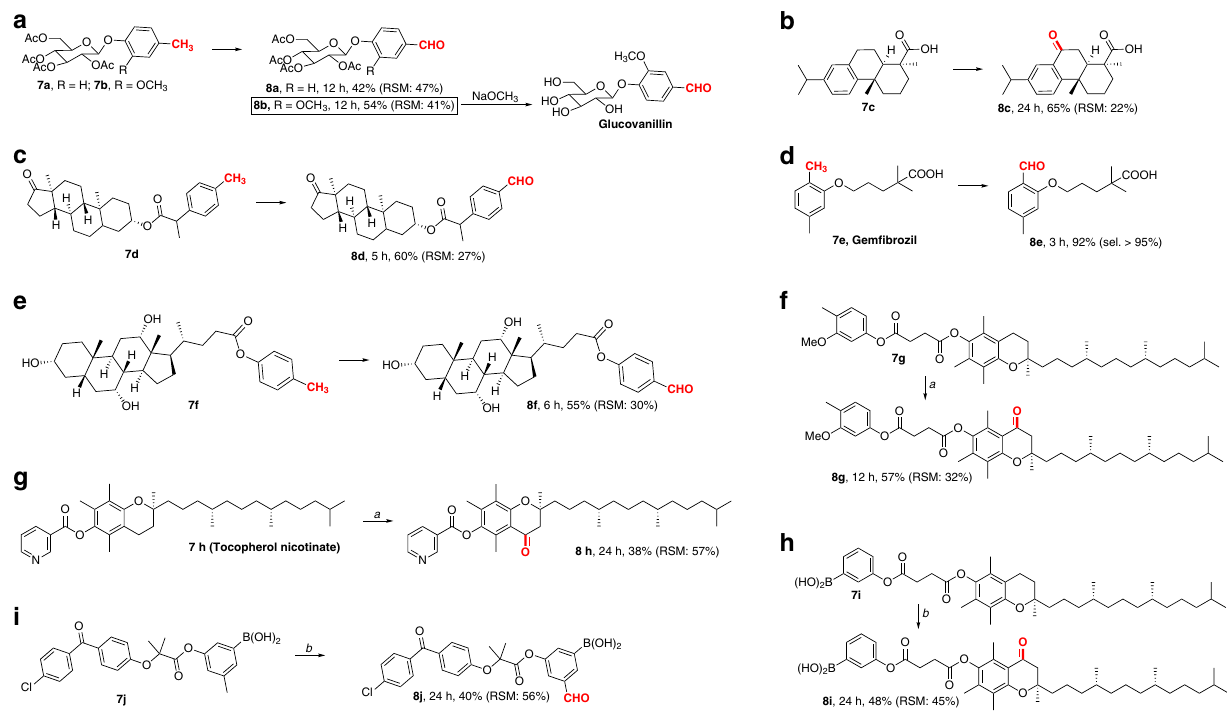
Fig. 4 Late-stage oxidation of complex molecules. a Oxidation of 7a and 7b ; b Oxidation of 7c ; c Oxidation of 7d ; d Oxidation of 7e ; e Oxidation of 7f ; f Oxidation of 7g ; g Oxidation of 7h ; h Oxidation of 7i ; i Oxidation of 7j . Reported yields are for the isolated products. Reaction conditions: substrate 7 (0.25 mmol), ferrocene (10 mol%), Fe(II) phthalocyanine (1 mol%), K 2 S 2 O 8 (0.25 mmol), PMHS (0.75 mmol), CH 3 CN/H 2 O (1:1, 2.0 mL), 80 °C, and